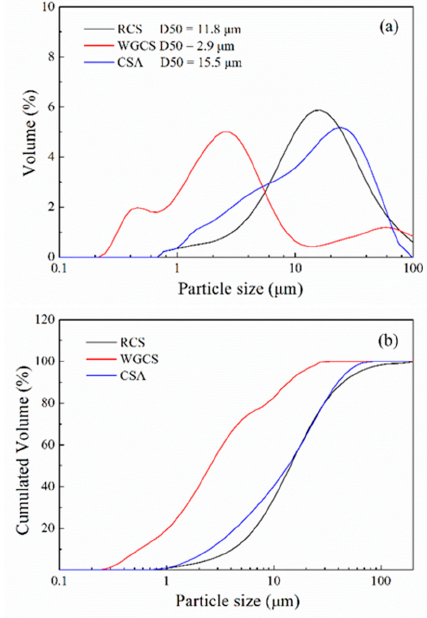
Figure 1. Particle size distribution of CSA, raw CS (RCS), and WGCS. ( a ) Volume; ( b ) Cumulated volume.